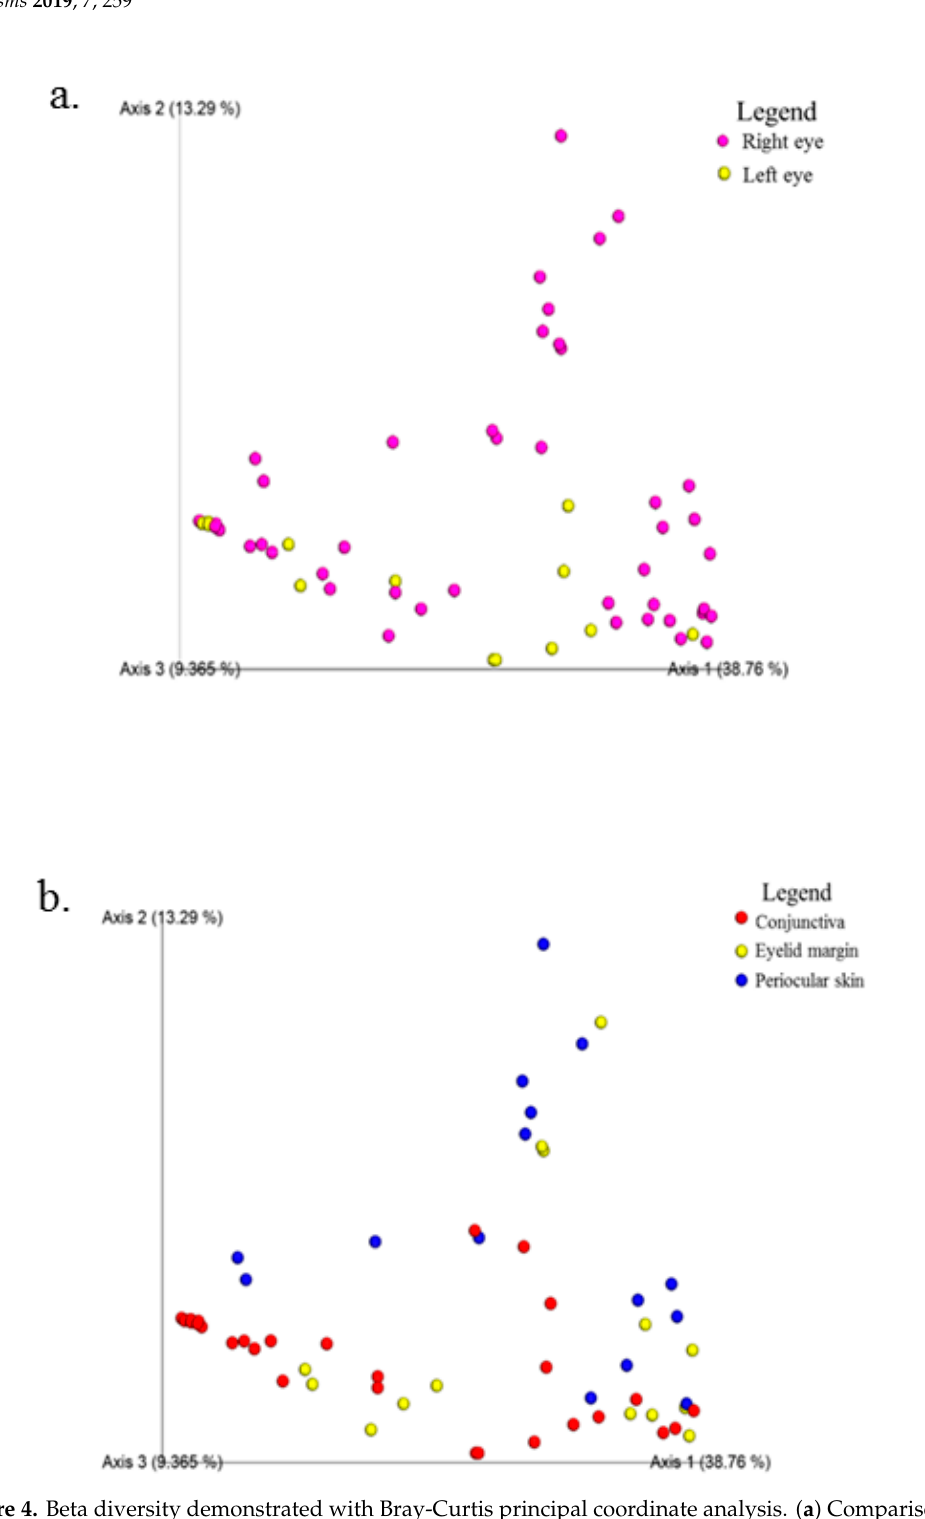
Figure 4. Beta diversity demonstrated with Bray-Curtis principal coordinate analysis. ( a ) Comparison of the right and left conjunctiva. ( b ) Comparison of the conjunctiva, eyelid margin, and periocular skin.